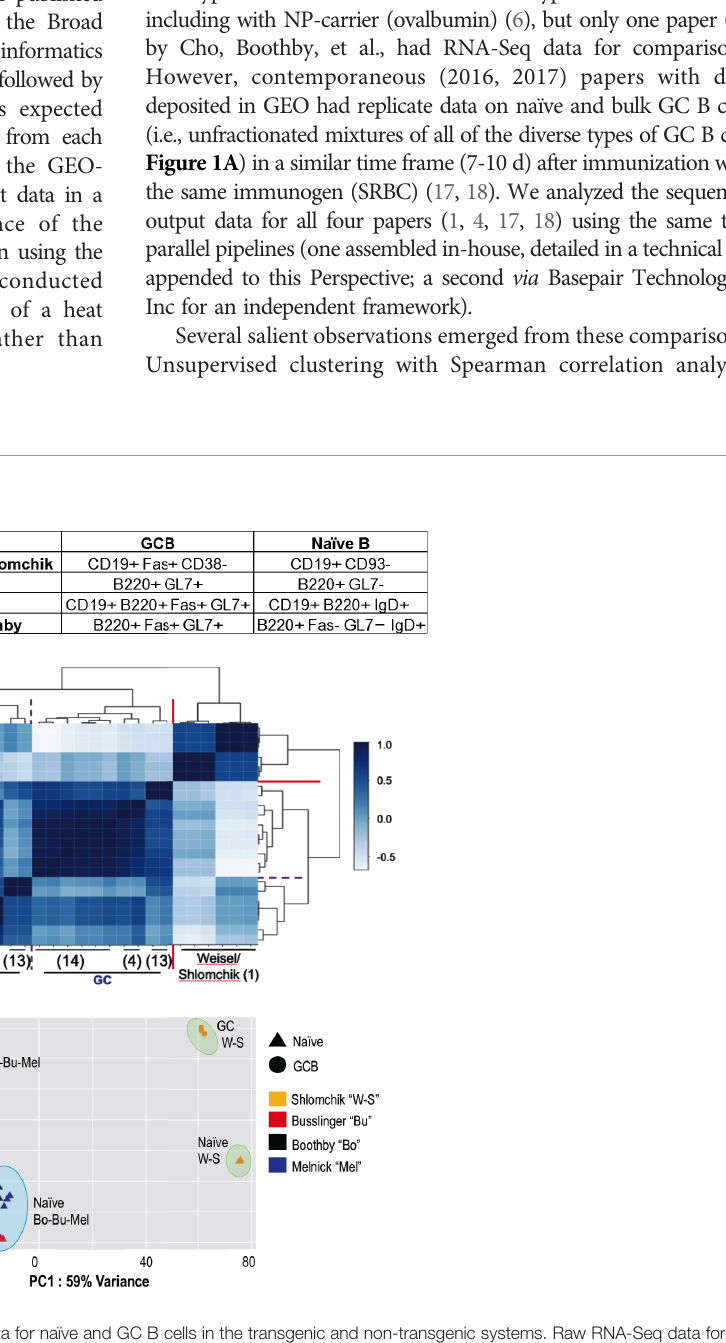
FIGURE 1 | Quantitative comparisons of the overall RNA-Seq data for naïve and GC B cells in the transgenic and non-transgenic systems. Raw RNA-Seq data for naïve and GC B cells were downloaded from the GEO deposits for the papers cited as (1), “ W-S ” (17);, “ Bu ” (4);, “ Bo ” (18); “ Mel ” , and put through each of two separate analysis pipelines applied uniformly to all data (detailed in the Methods and technical log). (A) A tabulation of the surface markers used to purify naïve (or naïve follicular) and total germinal center B cells in the papers analyzed. (B) Self-organizing map from unsupervised clustering based on Spearman correlation coef fi cients across the data sets of the papers cited as (1, 4, 17, 18). Darker blue represents strong positive correlation (1.0 = identical across the RNA-Seq data); lightest blues are anti-correlated. (C) Shown here, a PCA plot depicting results across the datasets for the indicated conditions (triangles, naïve; circles, GC B cells) and datasets (color-coded as to the paper linked to each GEO data set according to the Legend) generated using the bespoke analysis pipeline detailed in the Methods and Technical Log (below). X- and Y- axes are de fi ned by PC1 and PC2, accounting for 59% and 27% of the variance across the datasets, respectively. The results match those derived by the fully independent analysis using the default settings in Basepair Technologies ’ pipeline (not